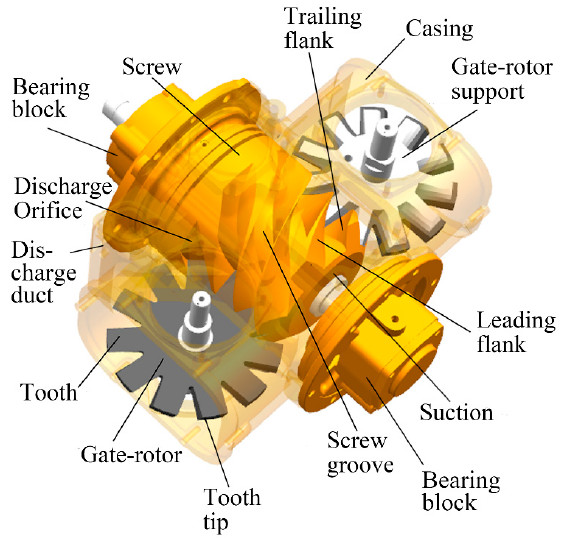
Energies 2020 , 13 , x FOR PEER REVIEW